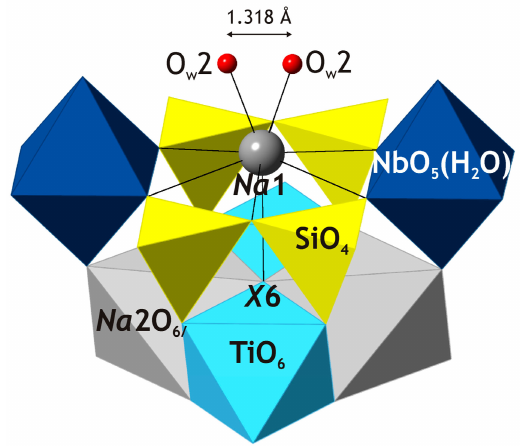
Figure 4. The local coordination environment of the Na 1 site in the crystal structure of shkatulkalite. Note that the O w 2 sites are partially occupied (site occupation factor = 0.37). Legend as in Figure